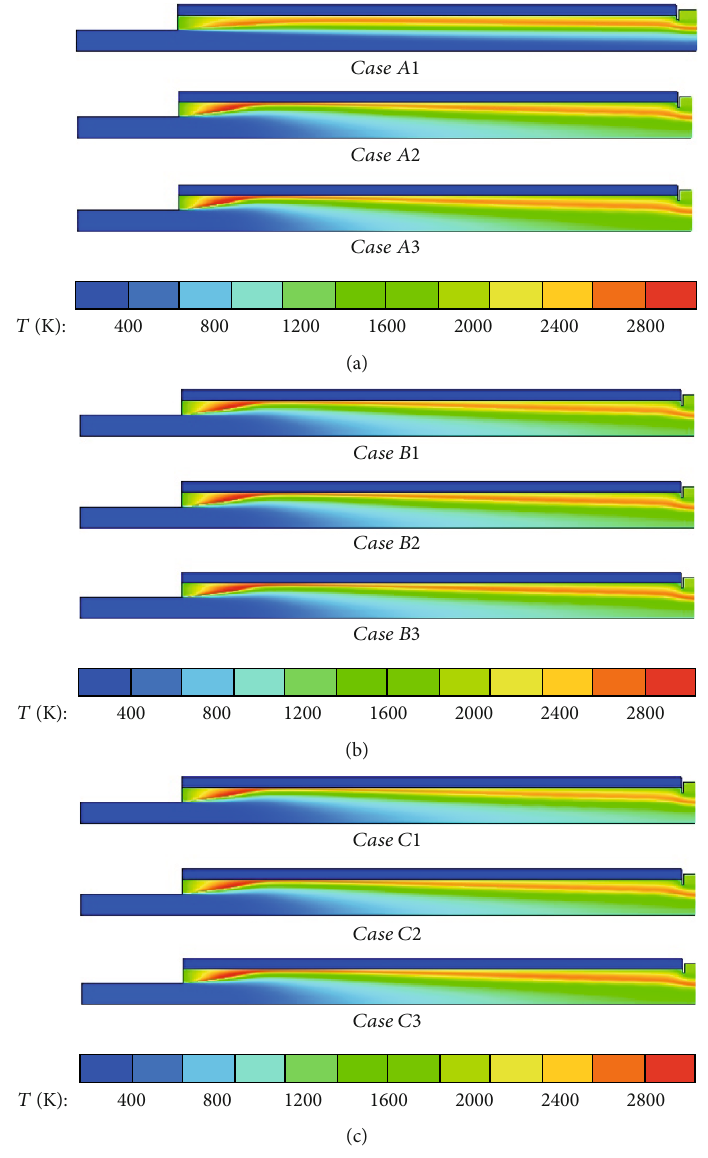
Figure 8: Temperature contours for the cases with di ff erent inlet